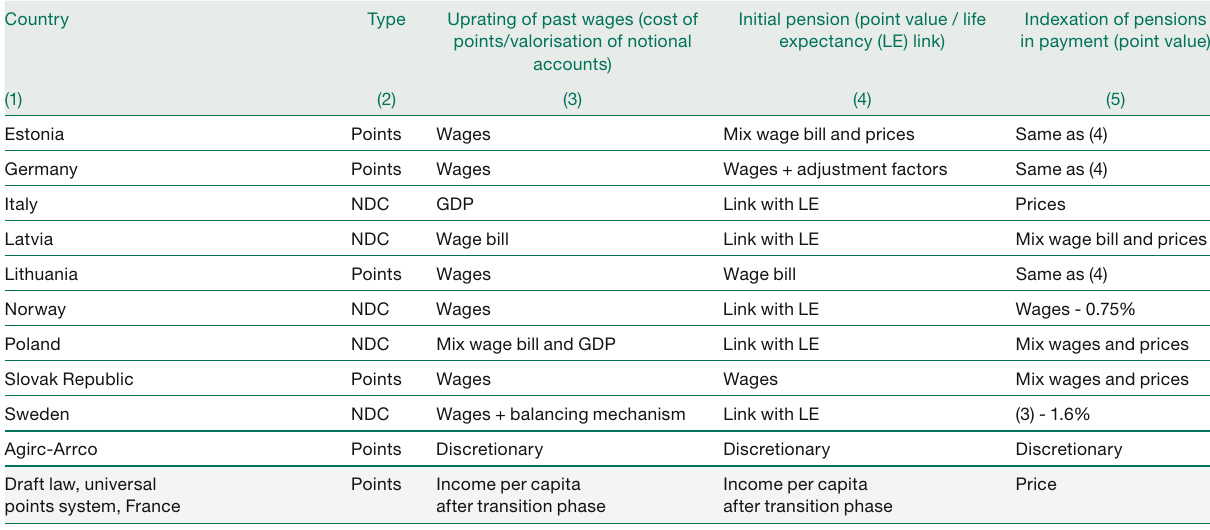
Rules for pension entitlements, initial benefi ts and indexation Points and NDC